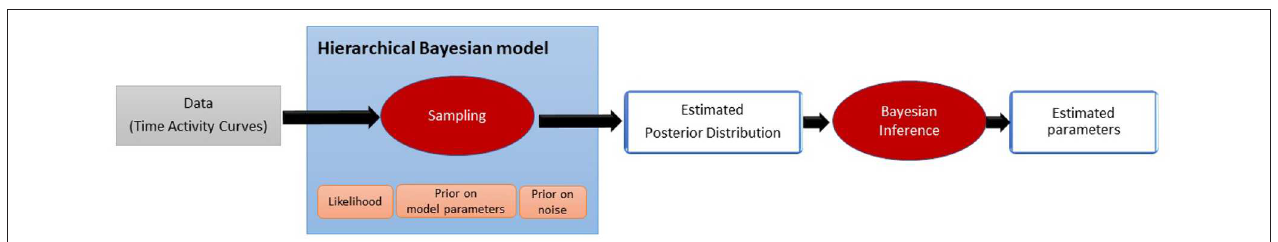
FIGURE 2 | Pipeline illustrating the proposed estimation process. The estimation of the posterior distribution is an intermediate step before estimating the final value of the